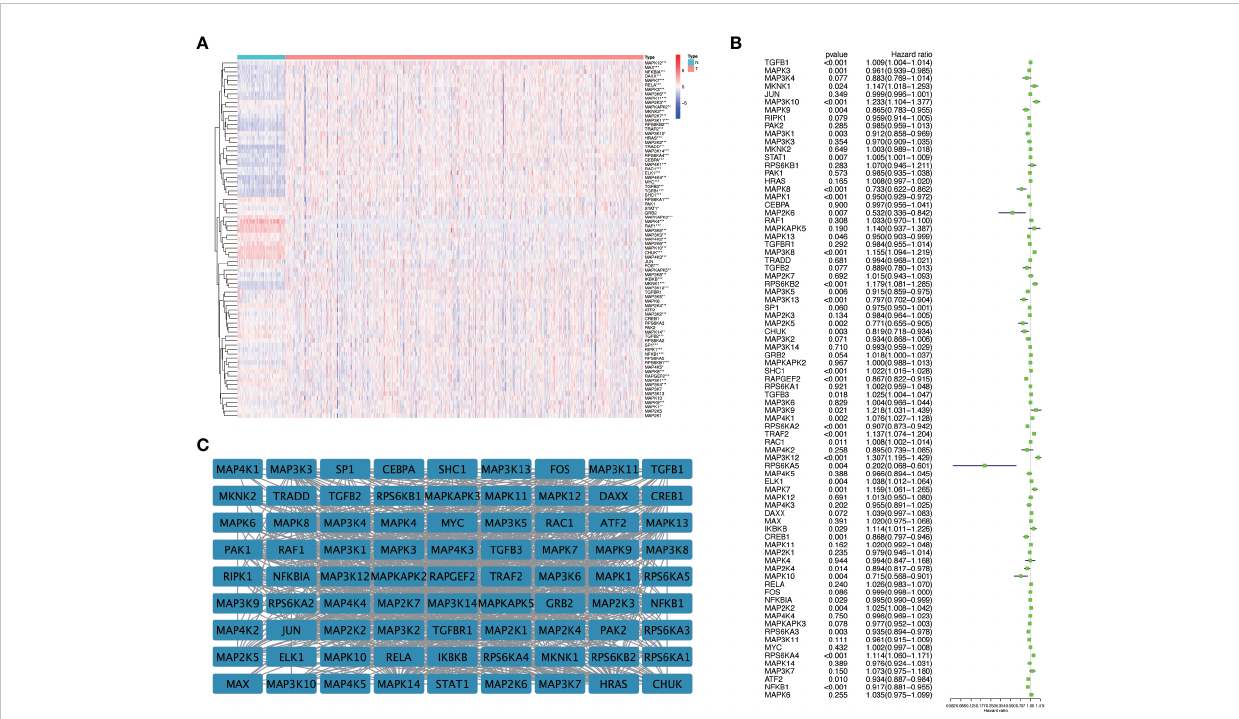
FIGURE 2 The expression of genes related to the MAPK signaling pathway in KIRC and univariate Cox regression analysis. (A) The differential expression of 81 MAPK signaling pathway-related genes in cancer and normal tissue in KIRC patients. Red represents the gene that is highly expressed in the tumor. The darker the color, the higher the expression level; blue represents the gene that is lowly expressed in the tumor, and the color the deeper it is, the lower the expression level. (B) Perform univariate Cox regression analysis on genes related to the MAPK signaling pathway. (C) The String database was used to analyze the protein interaction of 81 genes related to the MAPK signaling pathway, and the Cystoscope software platform was used to visualize the analysis results. *P<0.05, **P<0.01, and